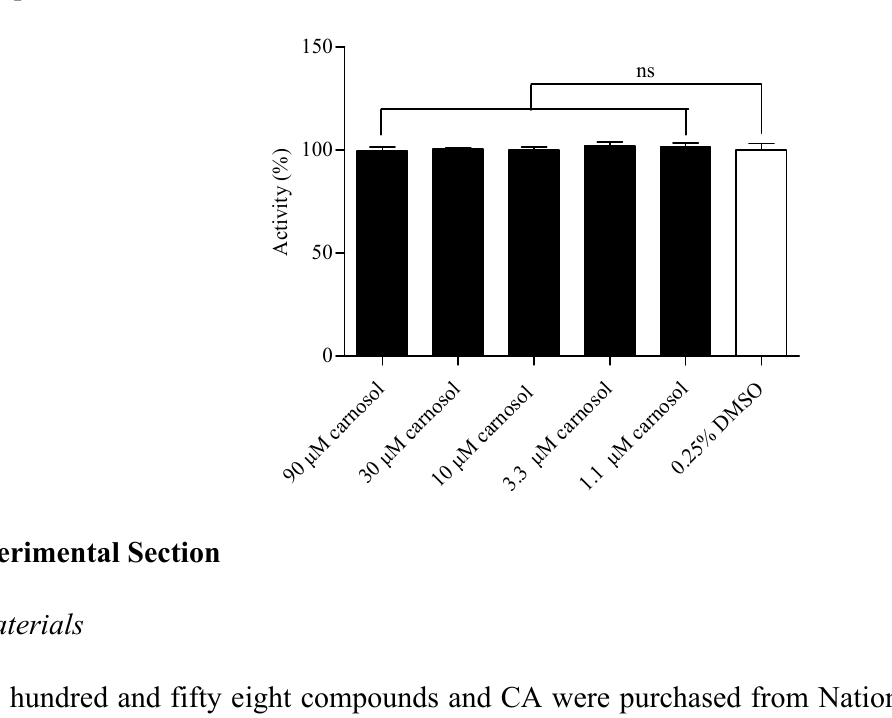
Figure 9. Cytotoxicity evaluation of carnosol in HEK293/TRPA1 cells. The cell viability was determined 2 h after compound stimulation. Values are means of replicates of three independent experiments ± standard